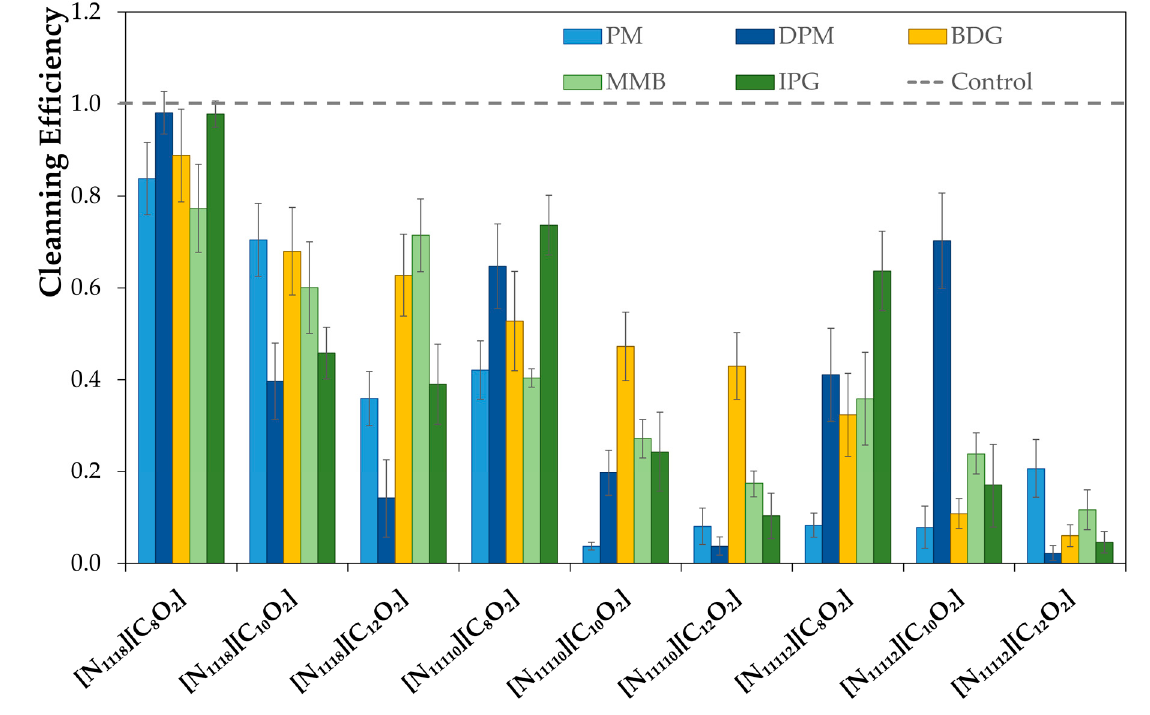
Figure 6. Cleaning efficiency of formulations with ionic surfactants in ceramic tiles obtained by abrasion scrub test: bars represent the cleaning efficiency of the formulation with different solvents, and error bars are the standard deviation (between 1% and 11%) of at least five independent measurements.